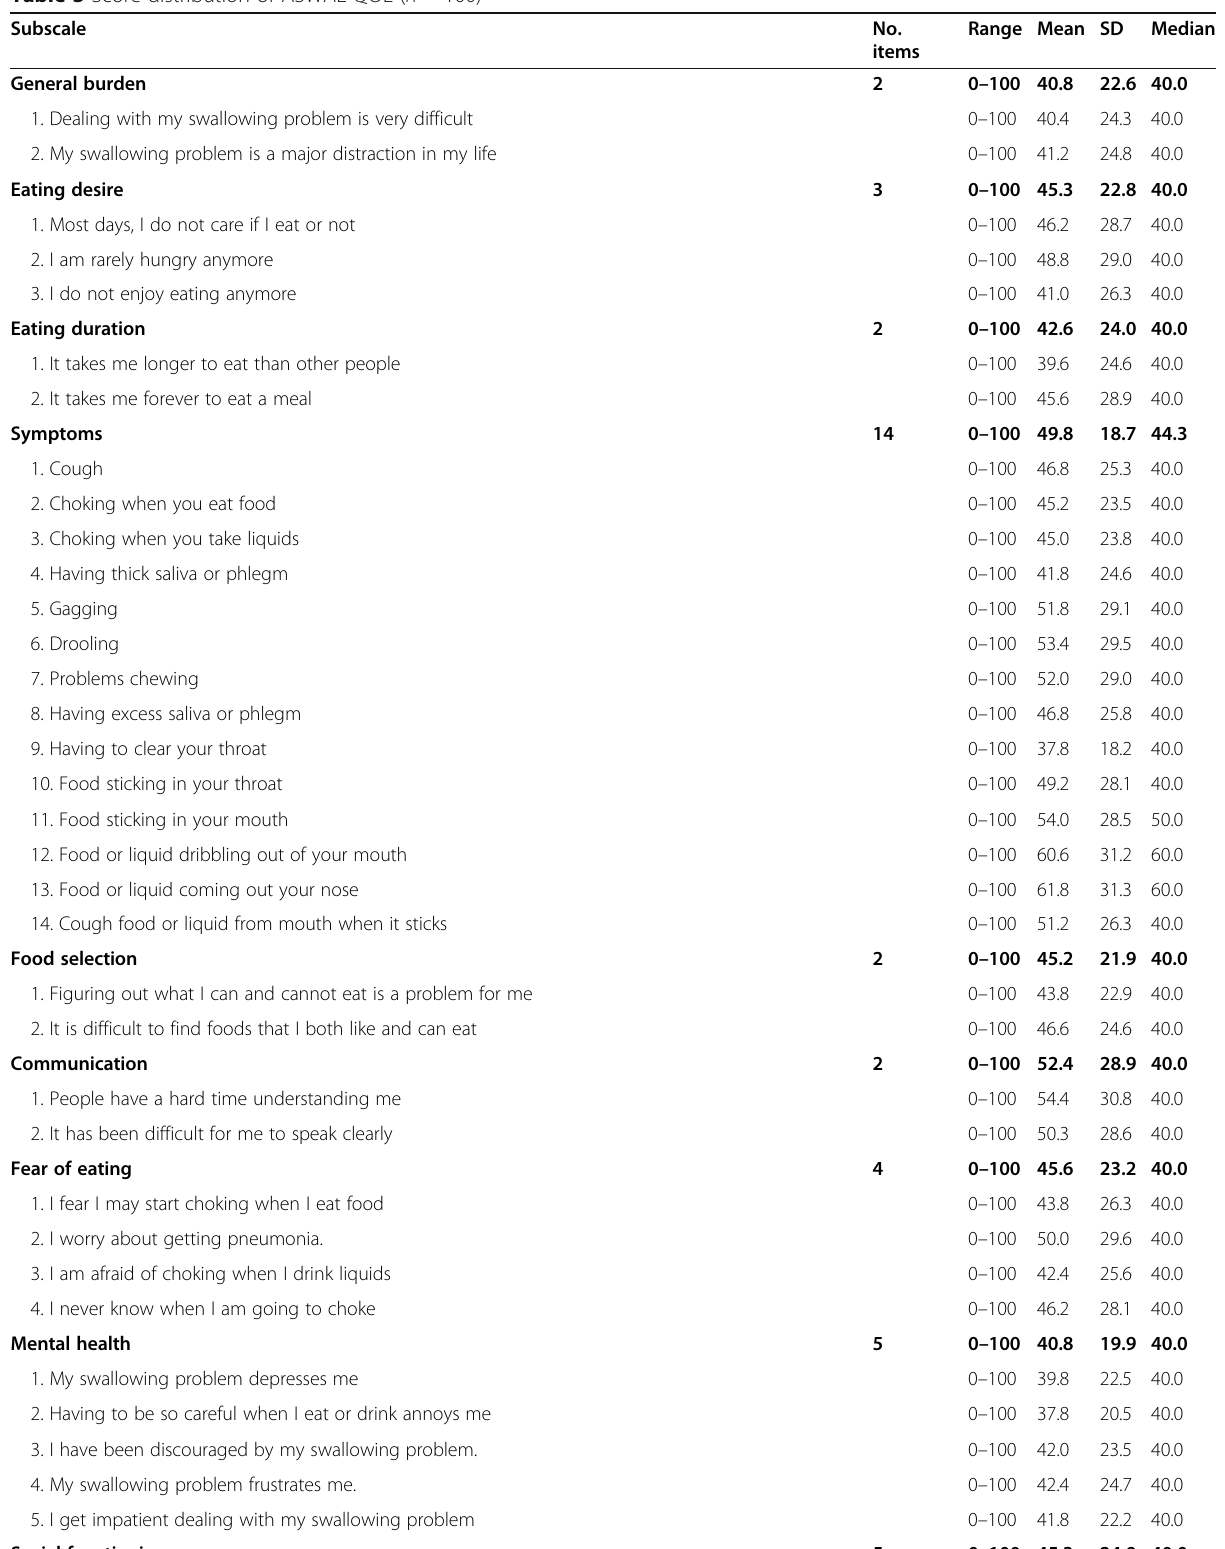
Table 3 Score distribution of ASWAL-QOL ( n =